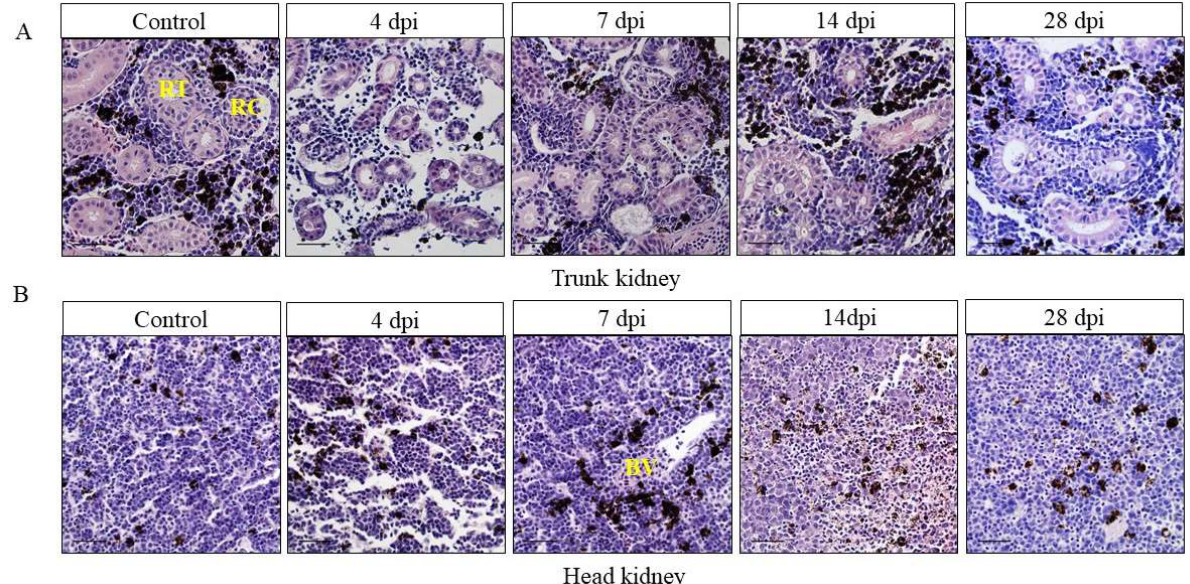
Figure 2. Pathological changes in the trunk kidney ( A ) and head kidney ( B ) of rainbow trout after infection with IHNV. After IHNV infection, rainbow trout kidney showed significant pathological changes in the infection group at 4, 7, 14, and 28 dpi compared to the control group (H&E). RT: renal tubular; RC: renal corpuscle; BV: blood vessel. Scale bar, 20 μm.